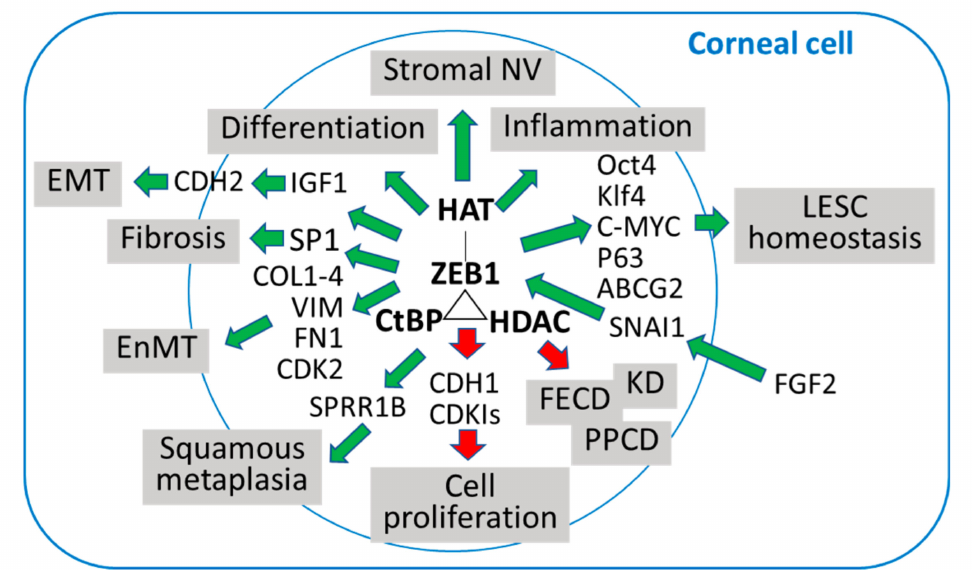
Figure 3. A schematic diagram demonstrating how the transcription factor ZEB1 up- (green arrows) and down- (red arrows) regulates expression of genes and related corneal disorders. HAT, histone acetyltransferase; CtBP, C-terminal binding protein; HDAC, Histone deacetylase; NV, neovasculariza- tion; EMT, epithelial to mesenchymal transition; EnMT, endothelial to mesenchymal transition; LESC, limbal epithelial stem cell; KD, Keratoconus; FECD, Fuchs endothelial corneal dystrophy; PPCD, posterior polymorphous corneal